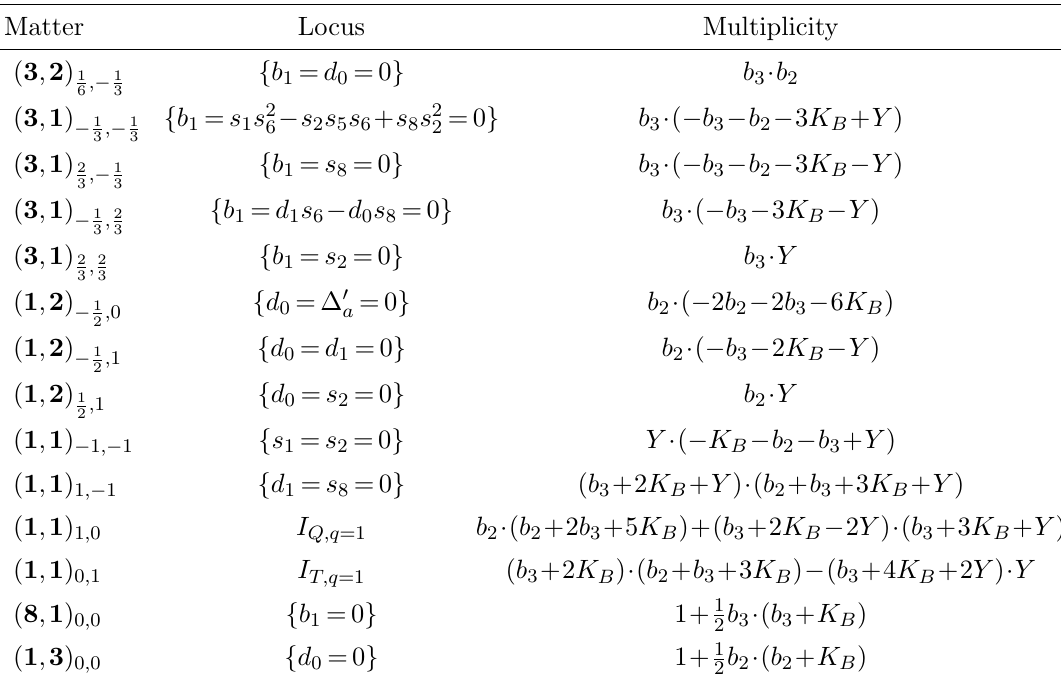
Table 5 . Matter spectrum for the model when d 2 ! 0, with multiplicities for a 6D model.